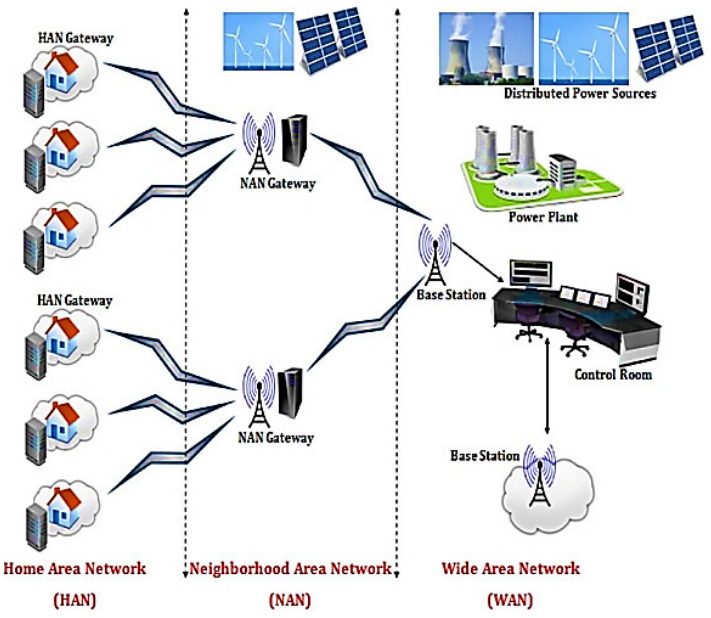
Figure 1. Smart Grid Communication Network.